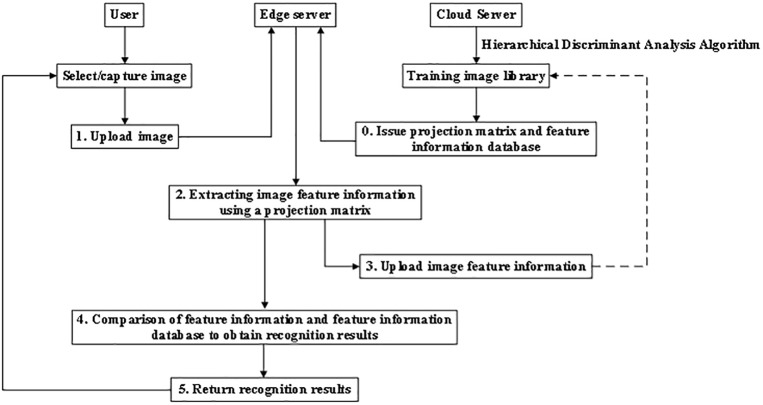
The image recognition process under MEC environment.